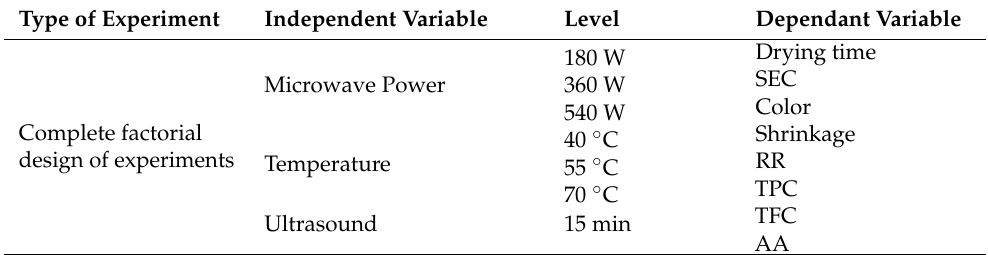
Table 1. Design of experiment